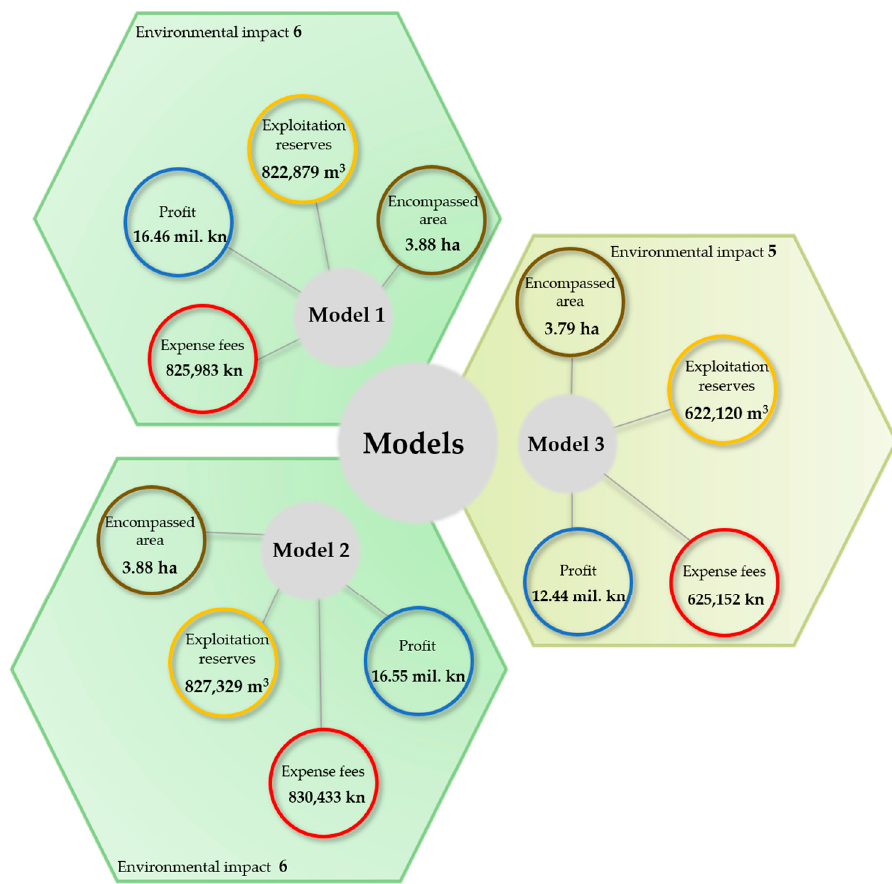
Figure 4. Models of final quarry contours with overview of selected evaluation criteria.